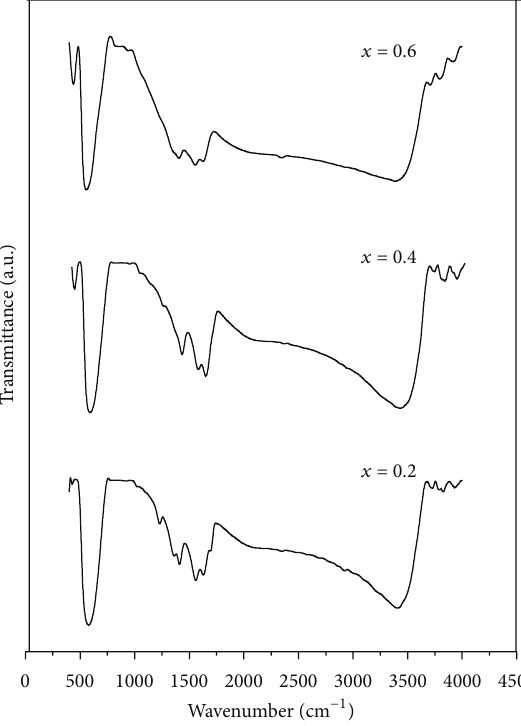
Figure 4: FTIR spectrum of NCZF.